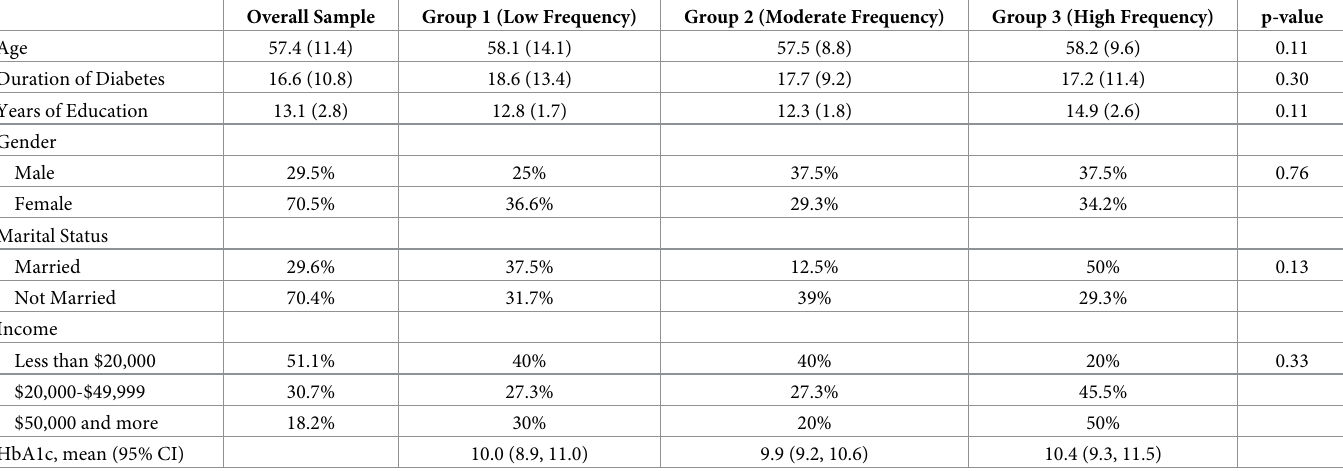
Table 1. Sample demographics for study overall and by intervention group.